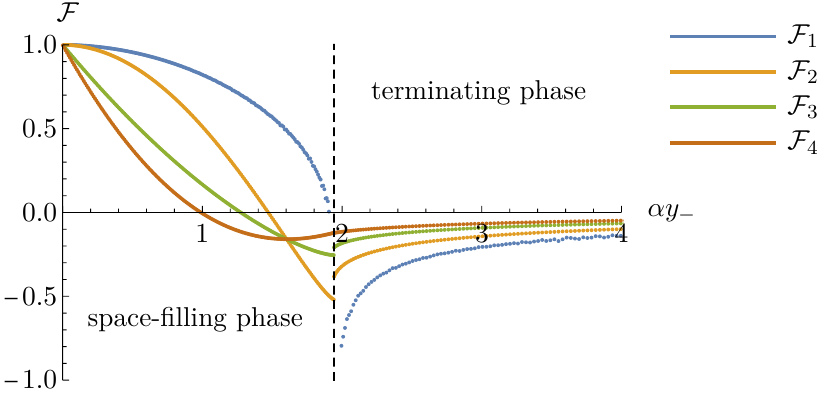
Figure 6. Plots of the F -functions (6.17) constructed from the D6-brane free energy in units with F D6,UV = 1 . The location of the quantum phase transition is indicated by the dashed vertical